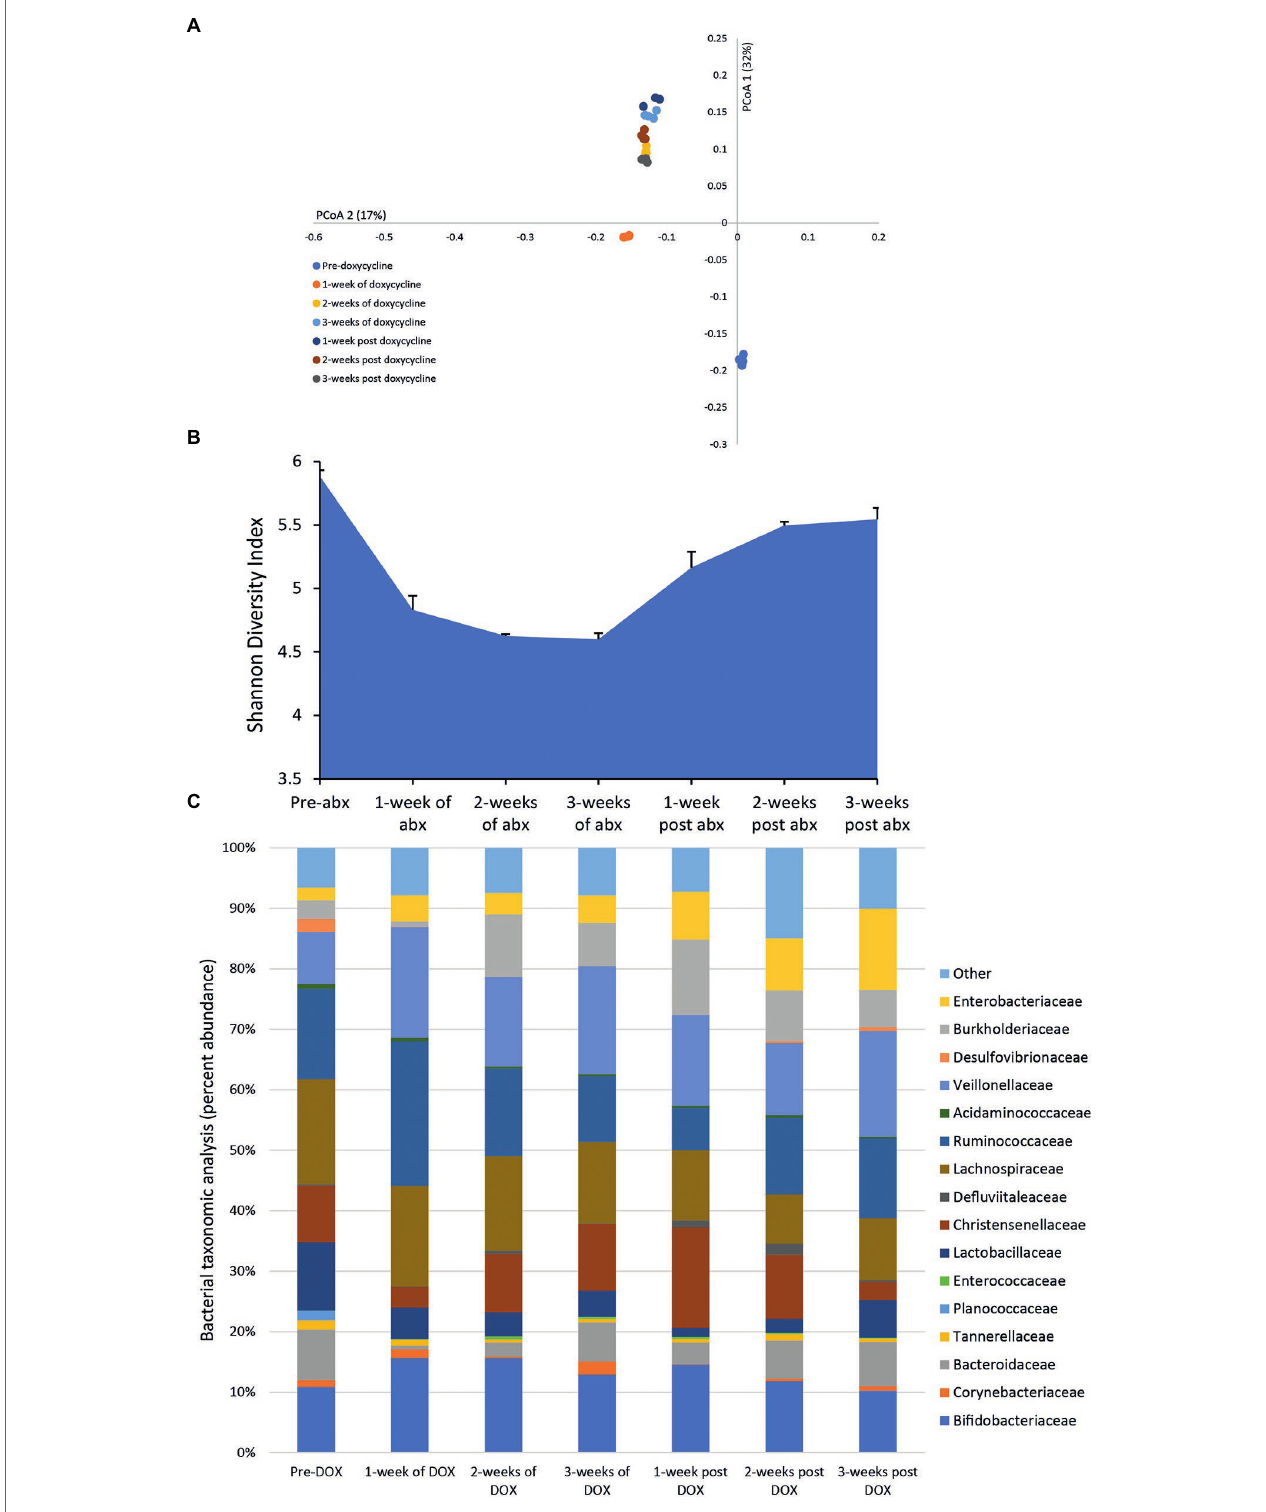
FIGURE 4 | Effect of doxycycline on the human microbiota. Changes to the microbiota profile during each week of doxycycline instillation and the recovery phase shown as a Principal Coordinate Analysis plot (A) . Results shown are four technical replicates. Changes in the microbial diversity after exposure to doxycycline and the recovery phase, as measured by the Shannon diversity index from four technical replicates (B) . Bacterial taxonomic abundance changes in response to doxycycline instillation (C) . Stacked bar graphs are mean percent abundance, from four technical replicates, analyzed from 16S rRNA